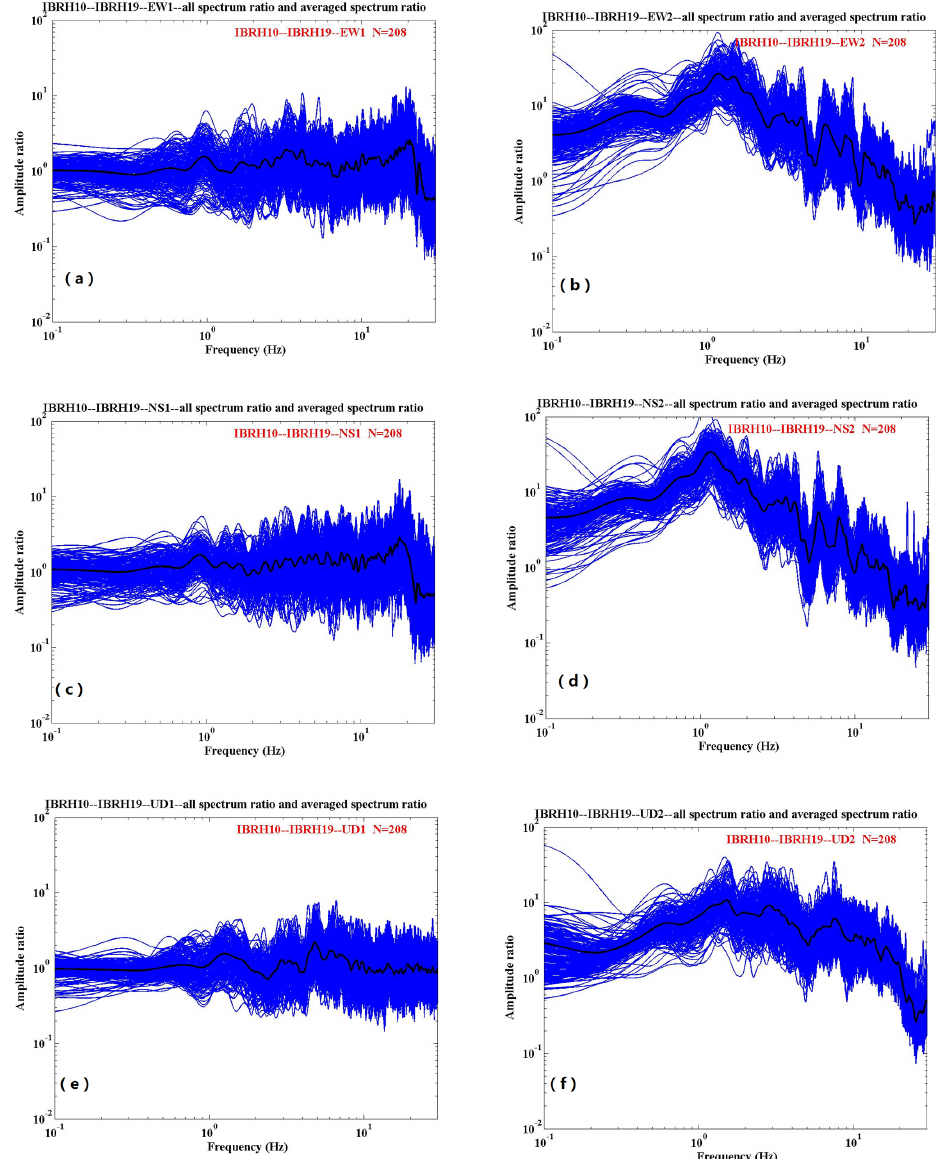
Figure 5. Spectral ratios of IBRH10 to IBRH19 for (a) EW1, (b) EW2, (c) NS1, and (d) NS2. (e) UD1. (f) UD2. The blue lines stand for the spectra ratio for every earthquake event, and the black line stands for the average spectra ratio for all the events. Table 2. Information for M 4 . 6 earthquake (IBRH101212070532). PGA (gal) PGA amp. I jma Boh. Surf. Amp. (surf. / boh.) Boh. Surf. Difference (surf. − boh.) Res. (sim. − obs.) Comp. Obs. Obs. Sim. Obs. Sim. Obs. Obs. Sim. Obs.